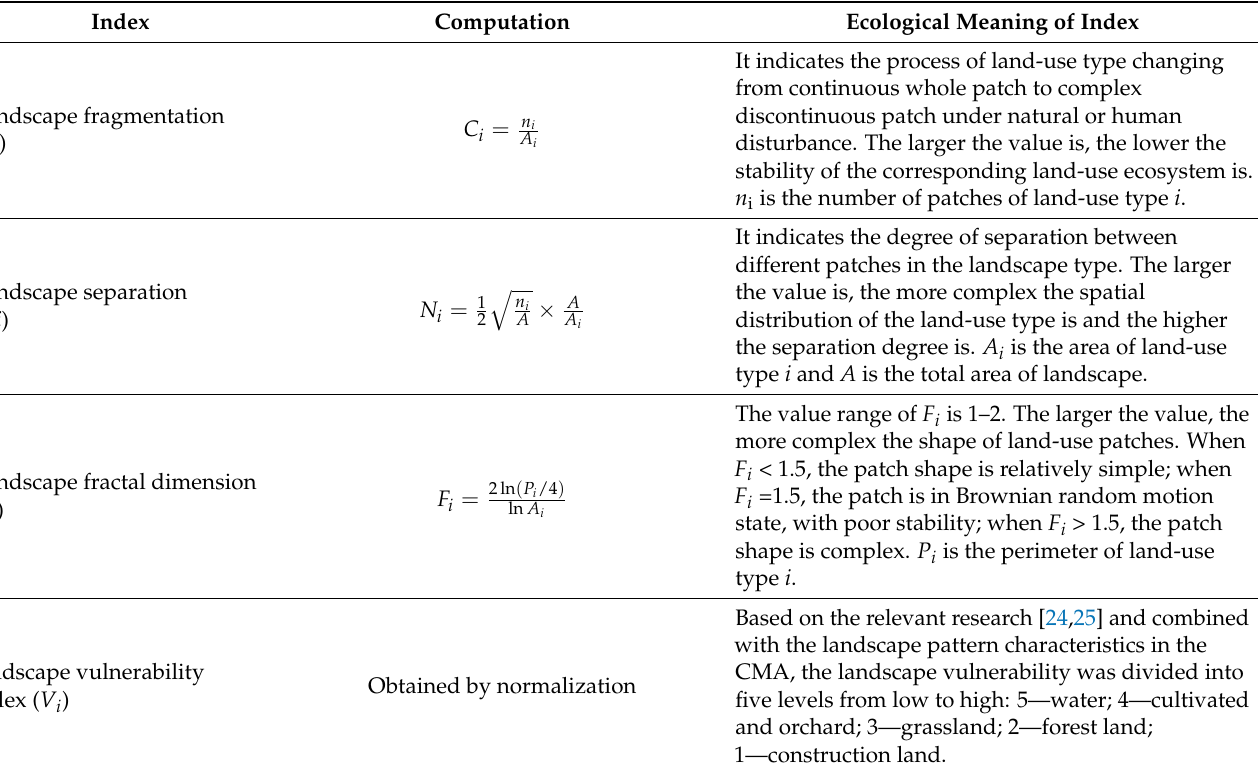
Table 2. Calculations of the landscape index and ecological